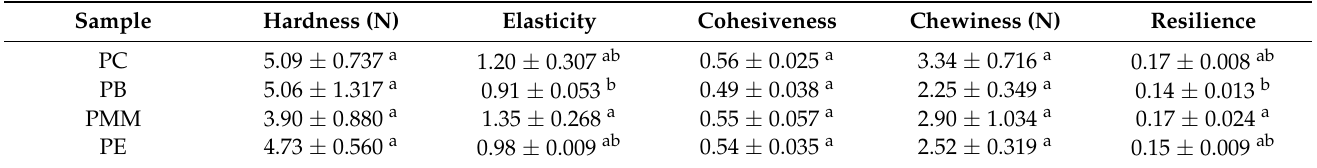
Table 2. Instrumental texture profile (TPA) of